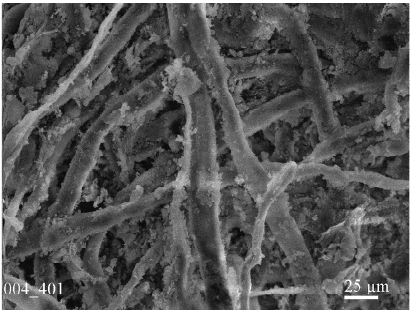
Figure 5. SEM image of the cellulose-hydroxyapatite membrane.